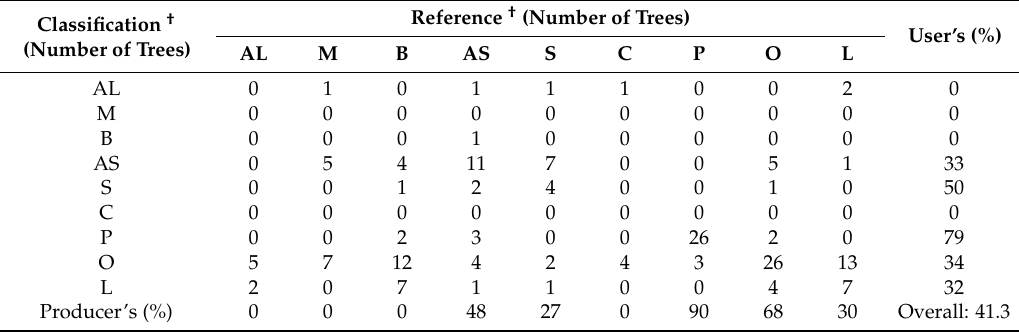
, dns C 1 , P C 2 and P C 3 25 10 10